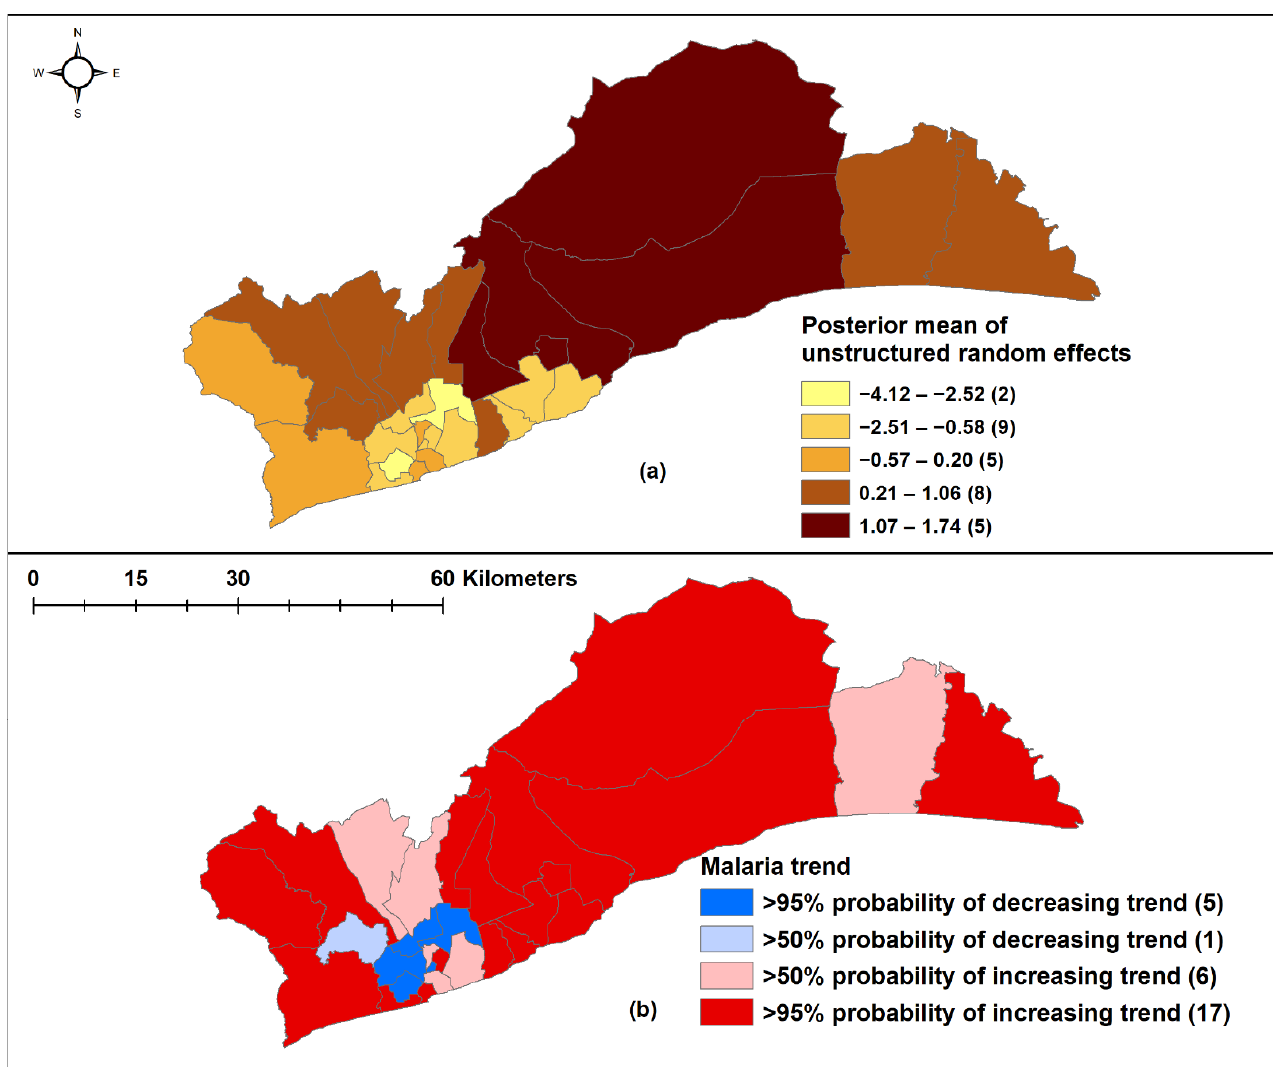
Figure 4. Spatial negative binomial regression analysis. ( a ) Unstructured random effects of malaria in Model I; ( b ) Trend analysis during the study period, 2015–2019. Source: Authors’ own contributions.